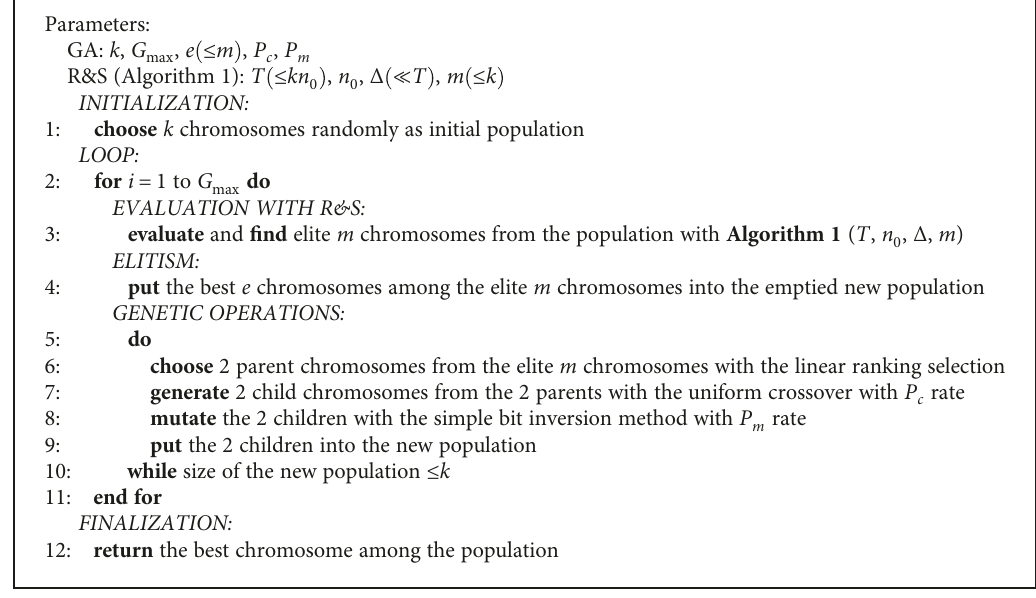
Algorithm 2: Proposed GA with